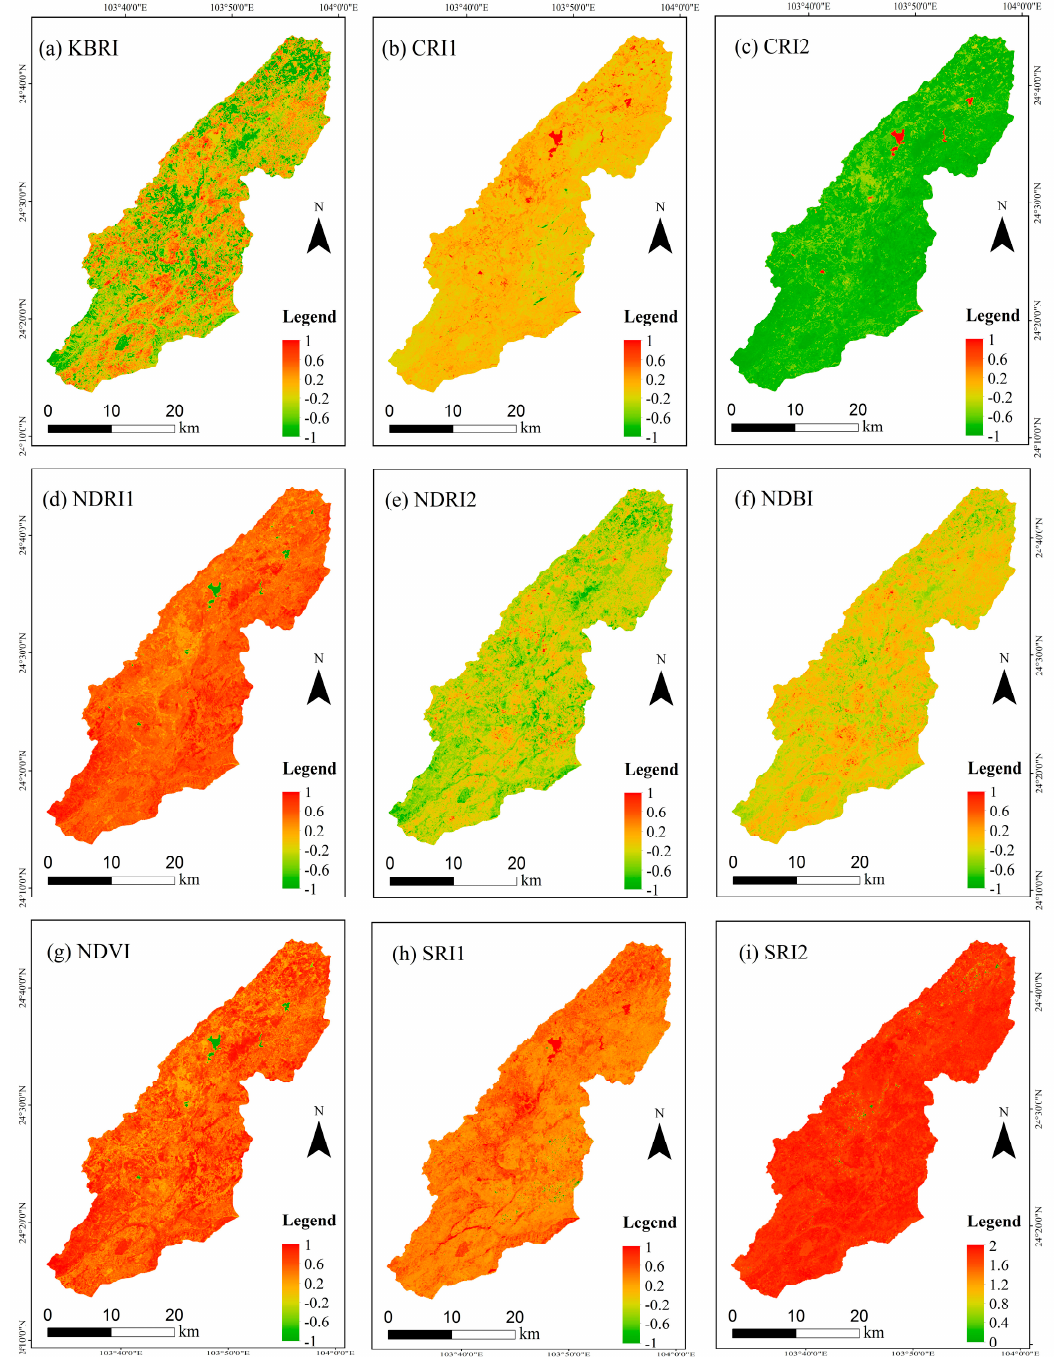
Figure 3. Index images of Xiaojiang watershed in color: ( a ) karst bare-rock index (KBRI); ( b